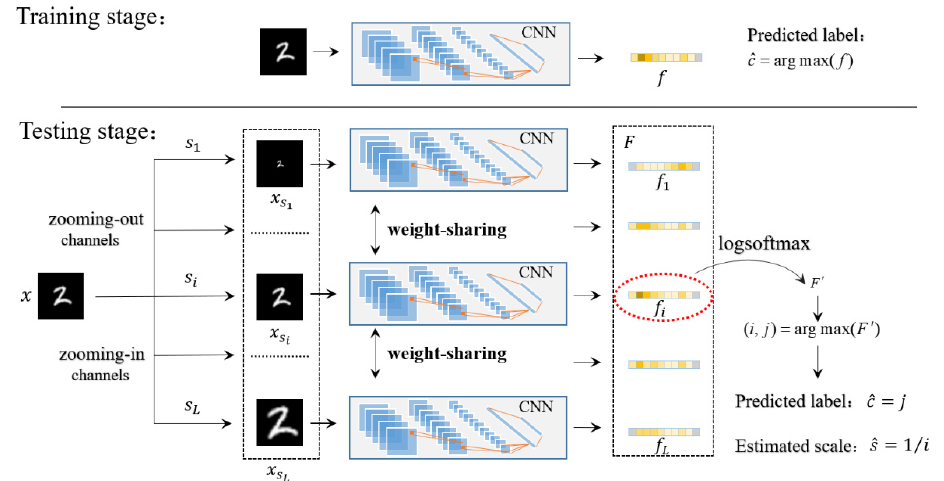
Figure 3. Diagram of the network architecture of the SA Net.